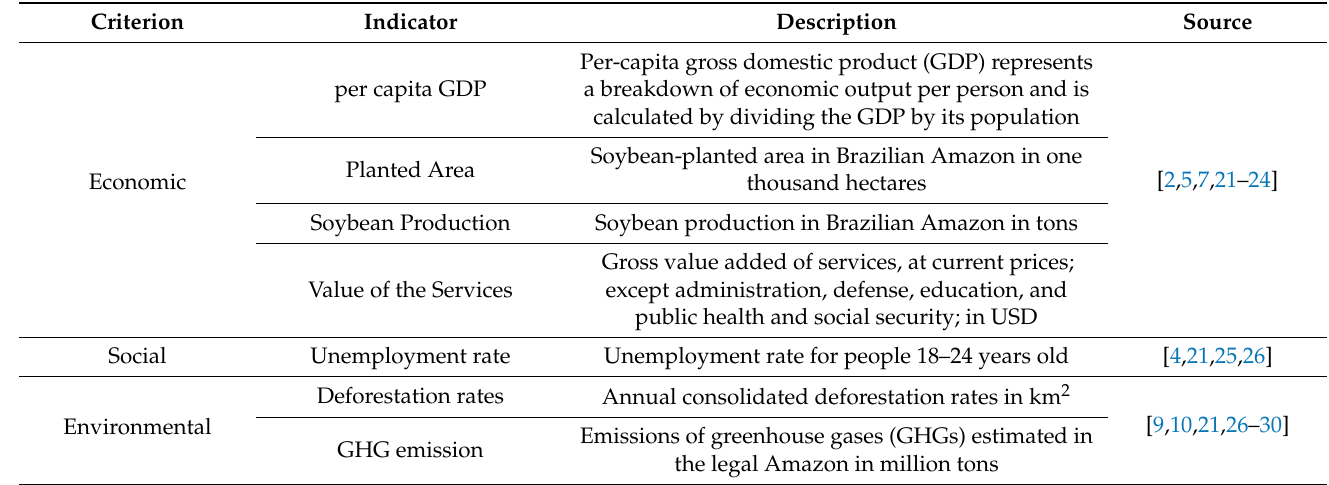
Table 1. Sustainability criteria and